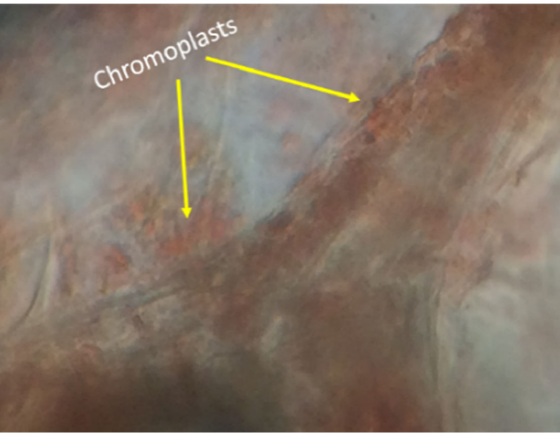
Figure 7. Chemical structure of tomato where chromoplasts are found.